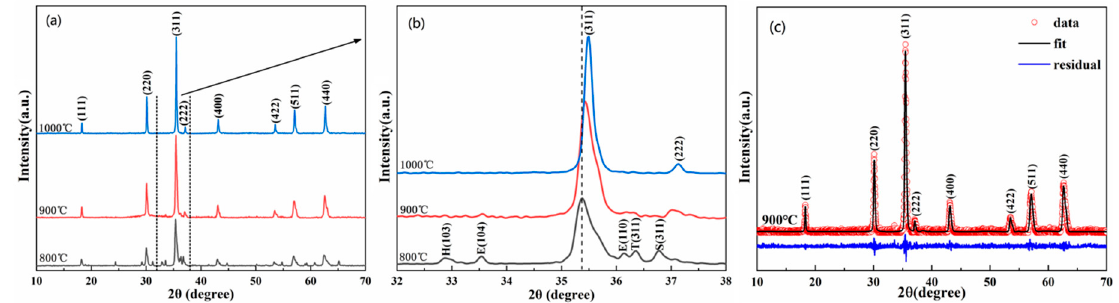
Figure 1. ( a ) X-ray diffraction (XRD) pattern of (FeCoCrMnZn) 3 O 4 powders calcined at 800, 900, and 1000 °C, respectively; ( b ) partially enlarged XRD patterns (32–38°), where peaks indexed with (E), (H), (T), and (S) correspond to eskolaite, hetaerolite, cobalt manganese oxide, and Co 3 O 4 -like spinel phases, respectively; ( c ) Rietveld refinement XRD pattern of the powders calcined at 900 °C.